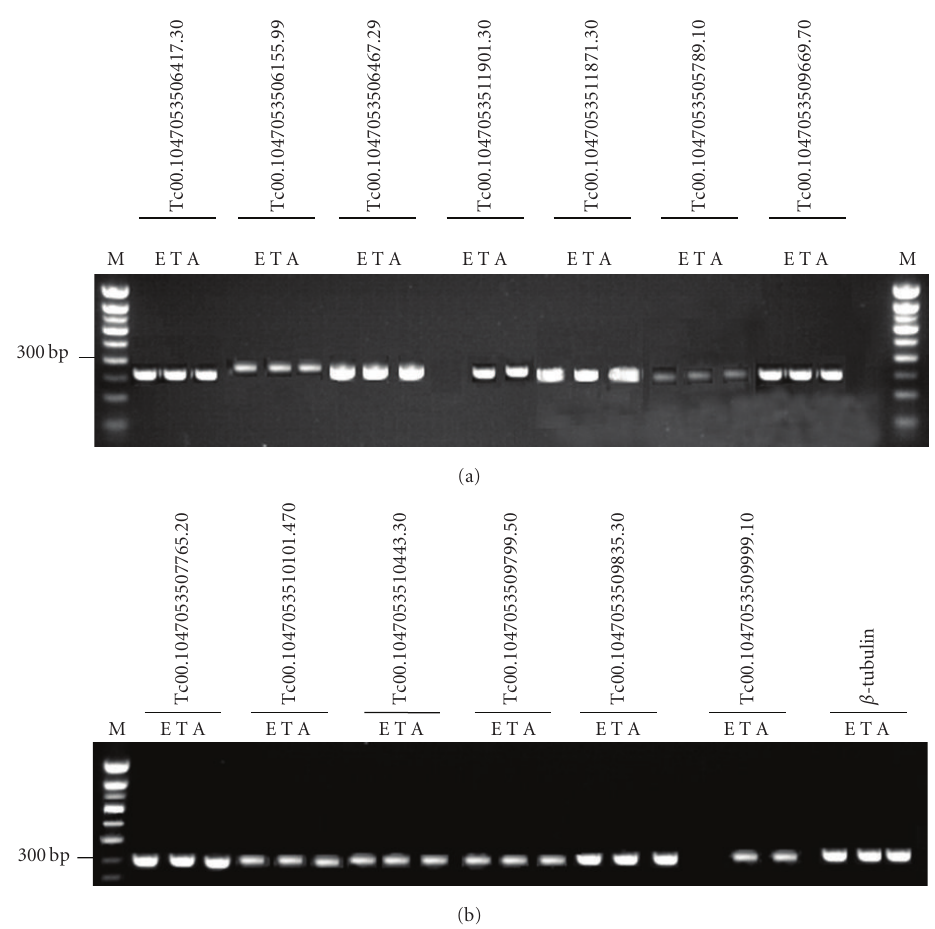
Figure 1: Amplification of the cDNAs encoding the potentially secreted proteins in the di ff erent stages of T. cruzi: RT-PCR analysis of total RNA from T. cruzi (clone derived from the Y strain) epimastigotes (E), trypomastigotes (T), and amastigotes (A). cDNA was amplified using gene-specific PCR primers (Listed in Table 1). Gene ID and expected lengths of cDNA are listed in order in Table 1. M: Molecular marker: Smart Ladder